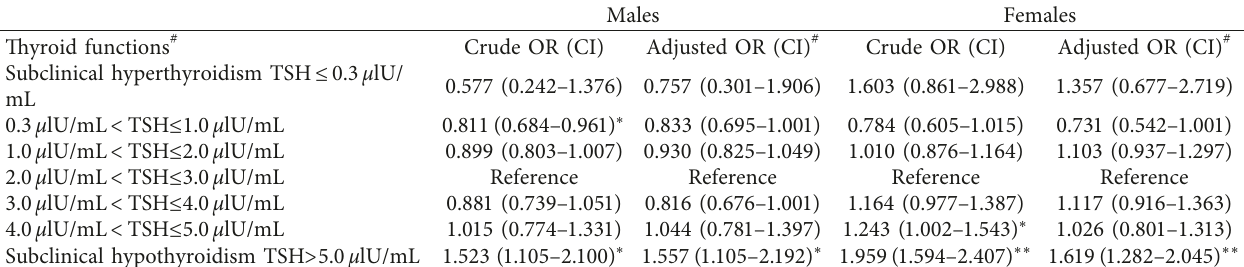
Table 3: Hypertension in different genders according to thyroid